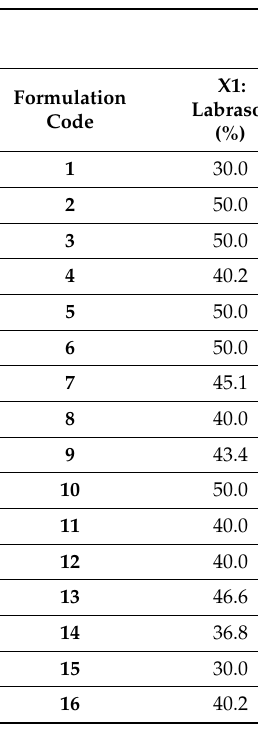
Table 1. Design matrix for the formulation of SNEDDS of Nifurtimox as per the D-optimal mixture